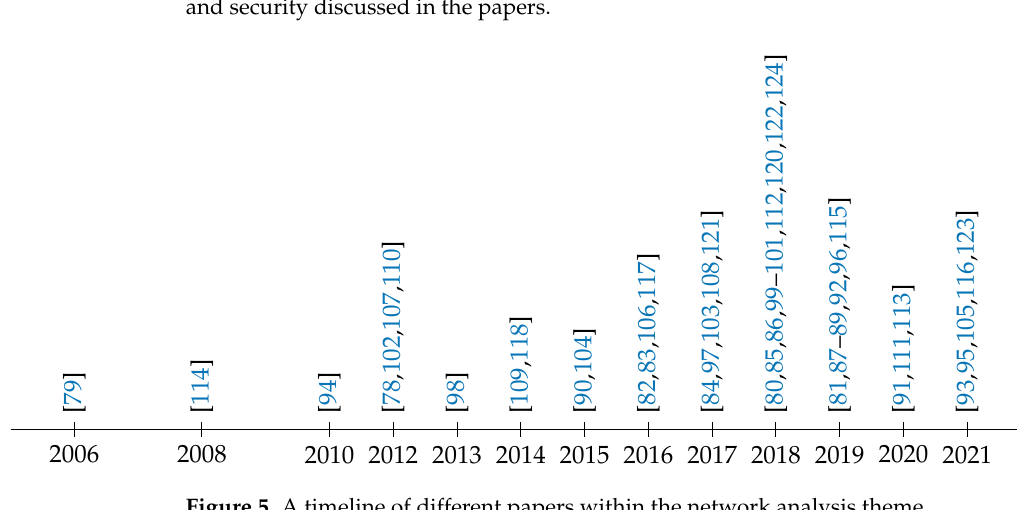
Figure 5. A timeline of different papers within the network analysis